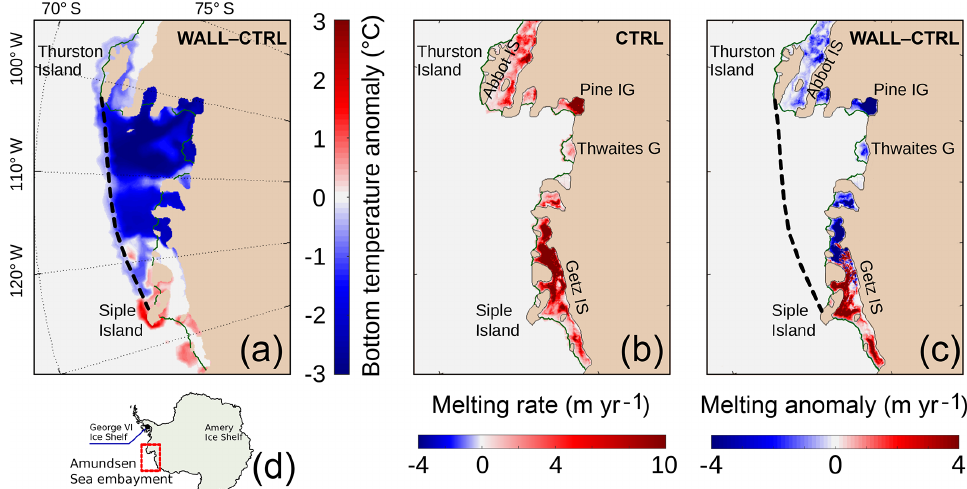
Figure 2. Simulated potential ocean temperature anomaly (WALL – CTRL) (a) and simulated basal ice shelf melting rates (CTRL) in (b) and its anomaly (c) . Panel (a) shows the simulated potential ocean temperature anomaly (WALL − CTRL) on the seafloor of the Amundsen Sea embayment and its adjacent ice shelf cavities. The location of the wall is marked as a dashed line, and the embayment region is defined in the map (d) . Panel (b) shows the simulated melting rates for the control run (CTRL), and panel (c) shows the basal melting anomaly (WALL – CTRL). Solid green lines highlight ice shelf edges. The following abbreviations are used: Abbot IS (Abbot Ice Shelf), Pine IG (Pine Island Glacier), Thwaites G (Thwaites Glacier) and Getz IS (Getz Ice